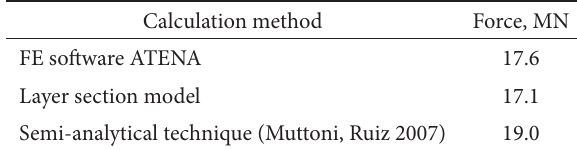
Table 3. Predicted pre-stressing force after